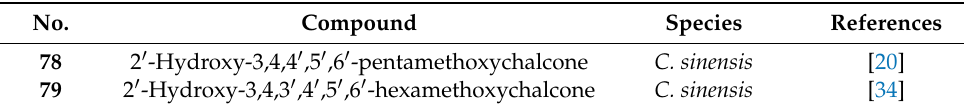
Table 3. Polymethoxychalcones identified in the Citrus